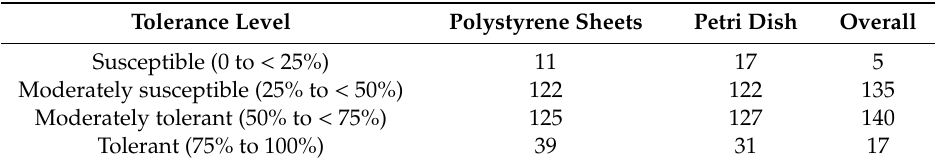
Table 1. Salt tolerance phenotype distribution of the tested genotypes under hydroponics (polystyrene sheets) and in petri dishes.